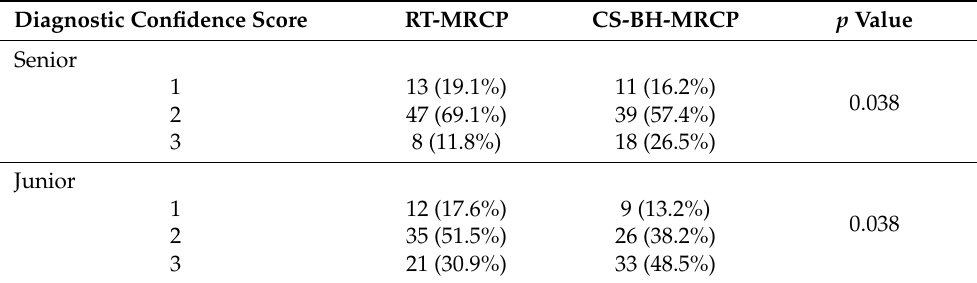
Table A5. Diagnostic confidence with RT-MRCP and CS-BH-MRCP sequences for senior and junior radiologists.